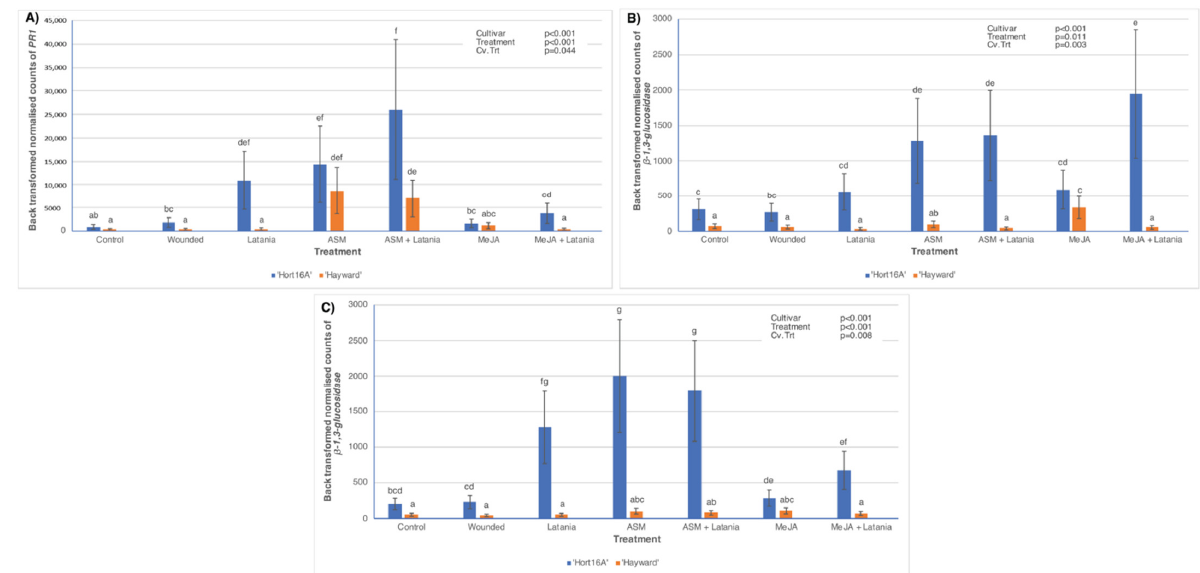
Figure 5. Defence gene expression measured by PlexSet ® NanoString in ‘Hort16A’ and ‘Hayward’ kiwifruit leaf tissue, in 2018, of salicylic acid (SA) pathway-related genes: PR1 , at seven days post scale infestation (psi) in ( A ); and β-1,3-glucosidase , at two days and seven days psi in ( B ) and ( C ) respectively. Treatments are described in full in Figure 2. Although leaves were sampled from both two and seven days psi for gene expression measurements, only the statistically significant cultivar × treatment interactions (Cv.Trt) are presented. There were five replicate plants per treatment. The Y-axis represents physical counts of the number of molecules expressed. Statistical analysis necessitated a log 2 transformation, but data are presented as back-transformed means ± standard errors. The Y-axis scale is different for each gene. P-values from ANOVA are shown in the top right-hand corner of each bar chart. Different lettering (a–g) indicates statistically significant treatment differences, as shown by LSD, p ≤ 0.05.